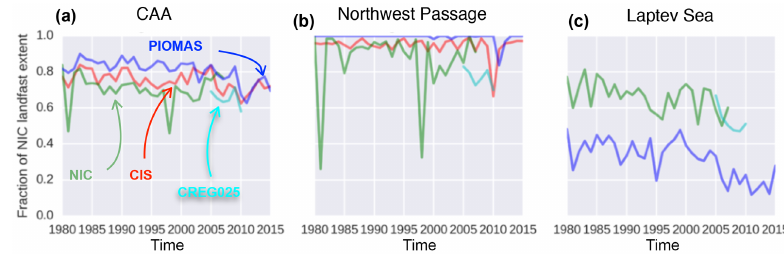
Figure 7. (a) Time series of the fraction of NIC landfast ice extent (magenta line in Fig. 2b) covered by landfast ice (slow, packed ice for PIOMAS and CREG025) with a duration of more than 5 months over the CAA. (b) Same as (a) but over the Northwest Passage. (c) Same as (b) but over the Laptev Sea.